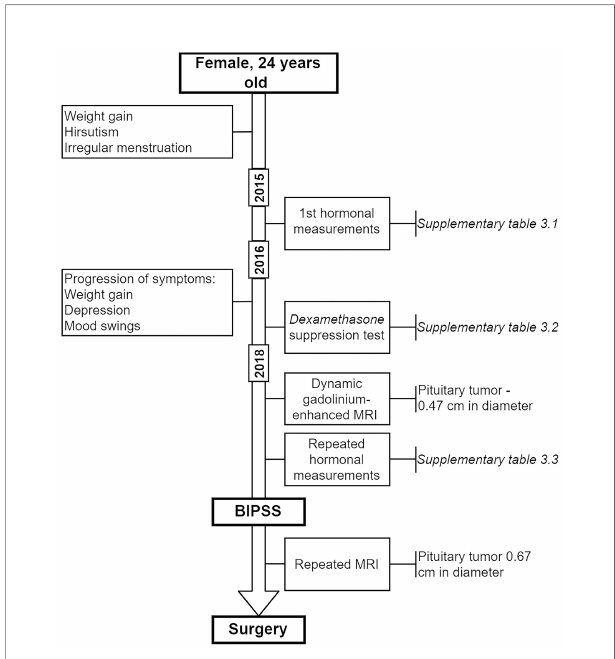
FIGURE 1 | Timeline of BIPSS